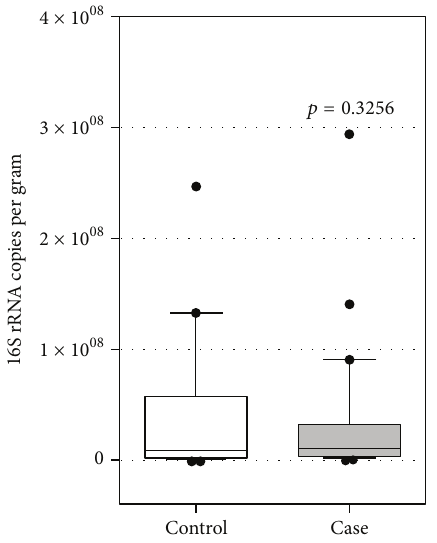
Figure 3: Relative expression of Lactobacillus spp. analyzed by RT- qPCR in stools of healthy (control) and constipated (case) children ( 𝑛 = 29-30 for each